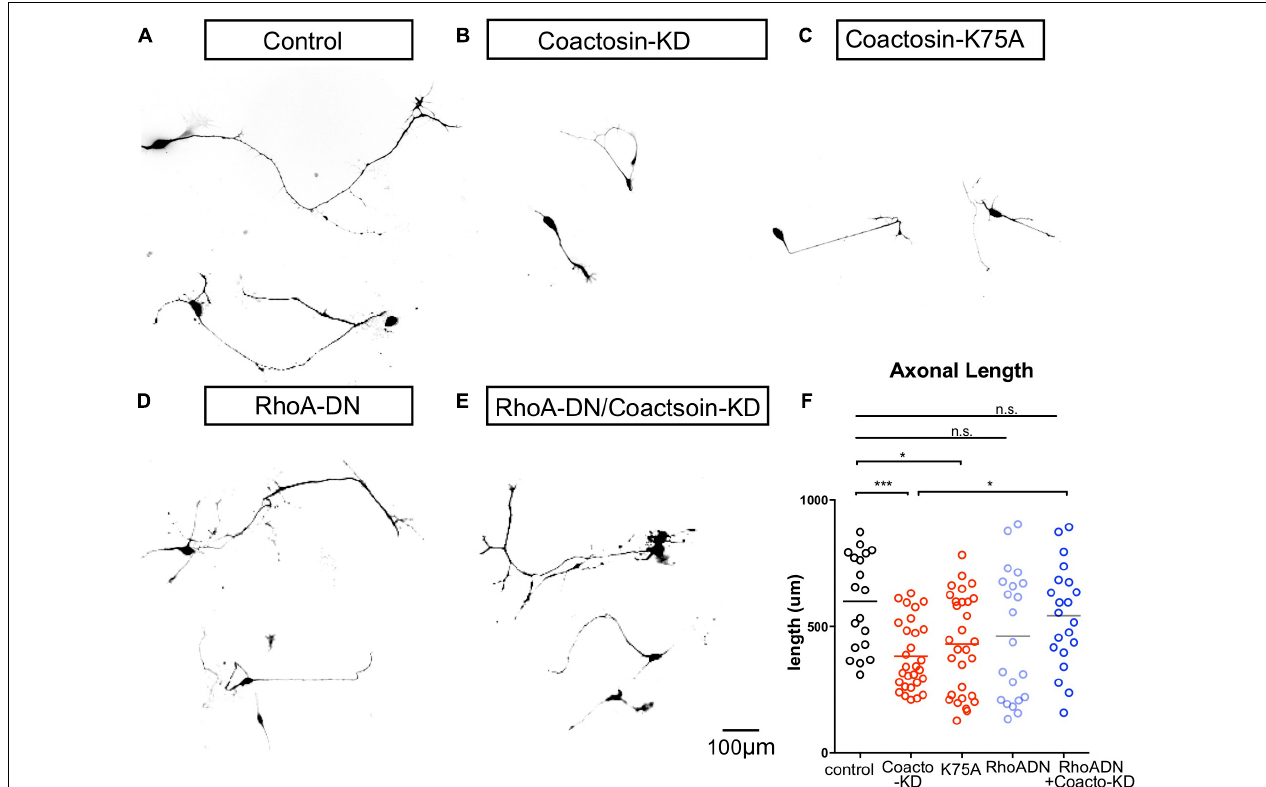
FIGURE 6 | Coactosin function during axon growth under Rho signals. (A–D) Effects of coactosin on the elongation of cultured oculomotor neuron axons. Oculomotor neurons were transfected with control shRNA (A) , coactosin shRNA (B) , coactosin K75A (C) , a dominant-negative form of RhoA (RhoA-DN) (D) , or coactosin shRNA plus RhoA-DN (E) . (F) Quantification of axon length in oculomotor neurons. The data are shown as means ± SEM of three independent experiments (19–30 neurons, * p < 0.05; *** p < 0.0001, one-way ANOVA).